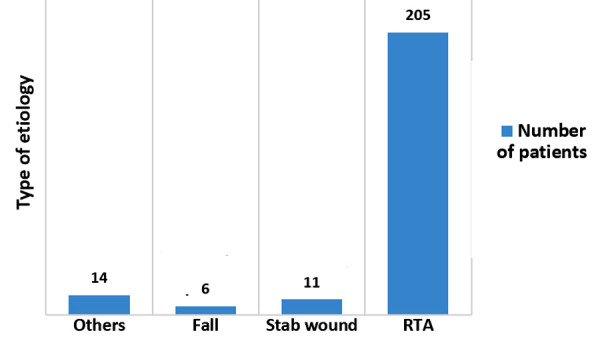
Etiology of trauma.